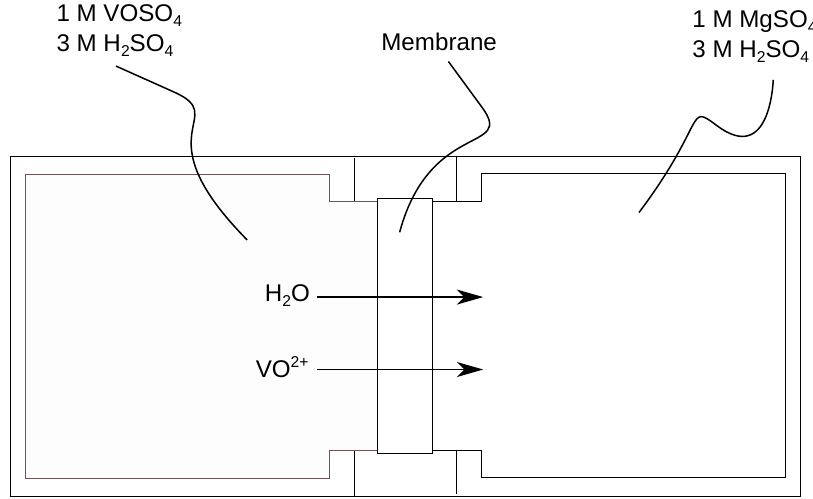
Figure 1. Schematics of a diffusion cell for vanadium permeation evaluation, indicating the VO 2+ transport and the water transport due to the hydration shell of the VO 2+ .